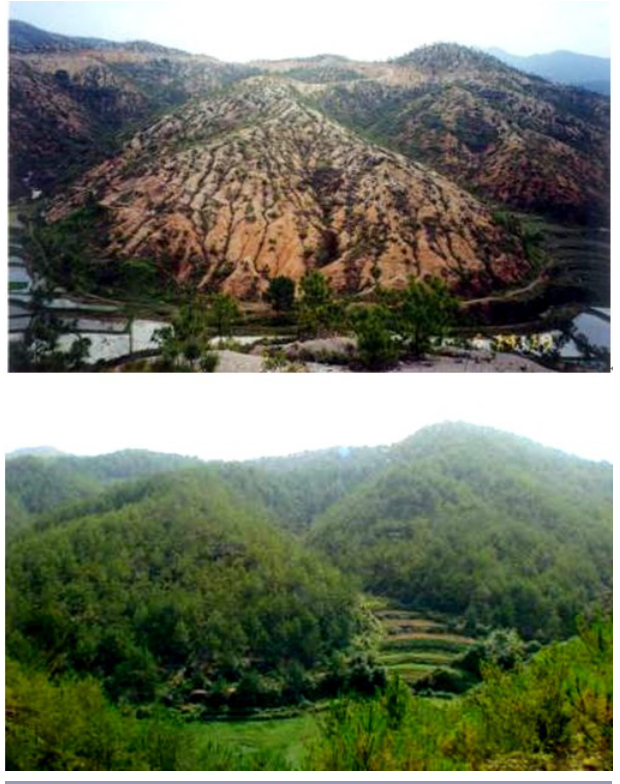
Fig. 2 . Changes in the landscape during the soil and water conservation project in Changting County in 2000 (Top) and 2008 (Bottom; Cao et al. 2009 a